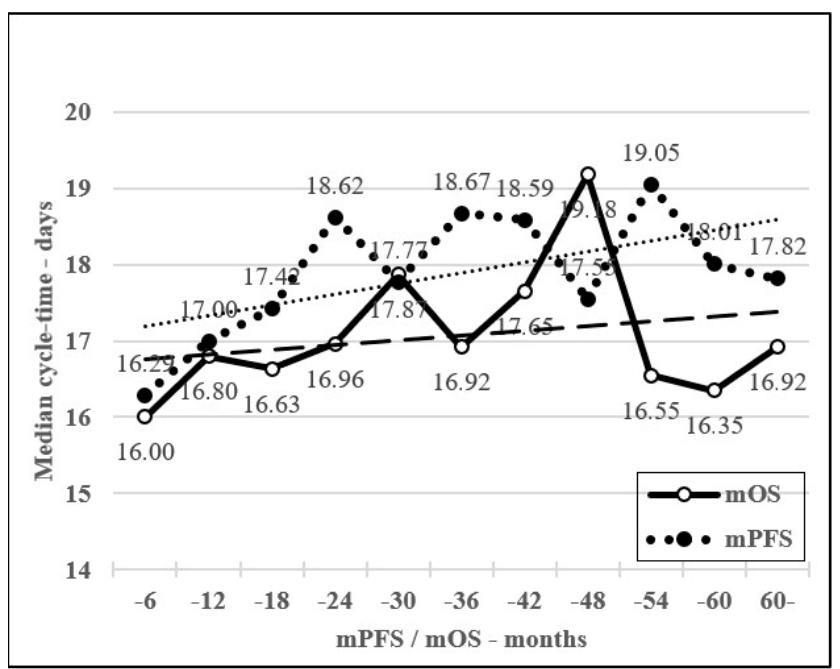
Figure 3. Median average cycle-time in incremental mPFS and mOS groups of 6-month subgroups and adherent trend lines.